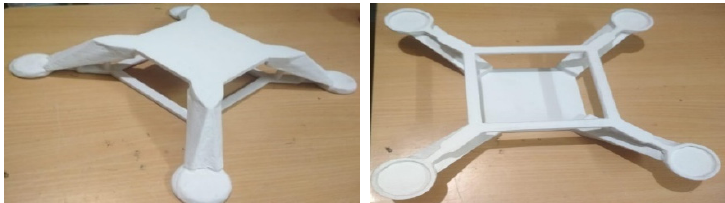
Figure 12. 3D printed structure.